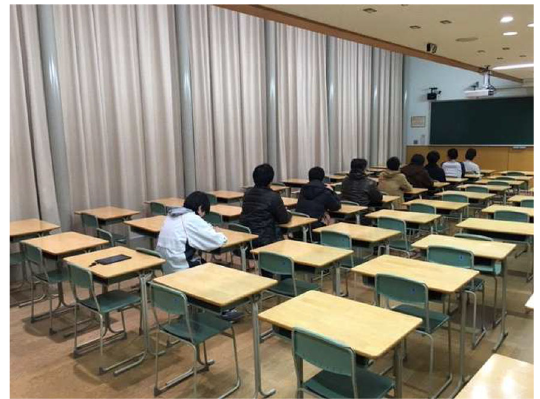
Fig. 11 Scene of survey on influence of human presence (9 students)